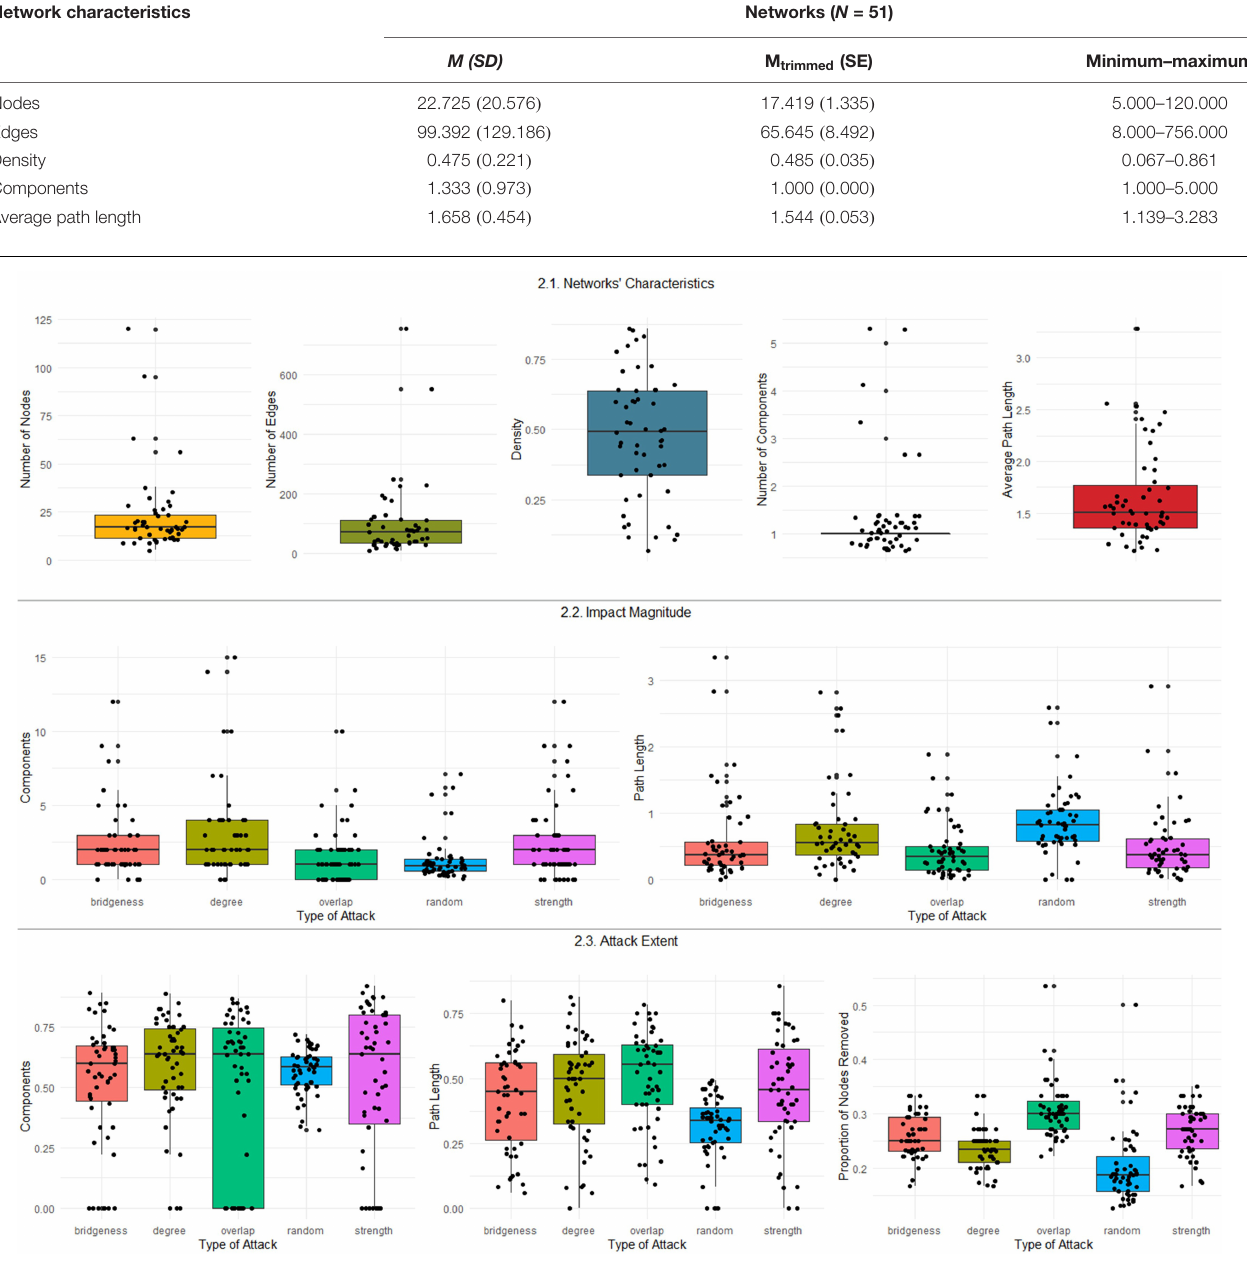
TABLE 1 | Network descriptives.